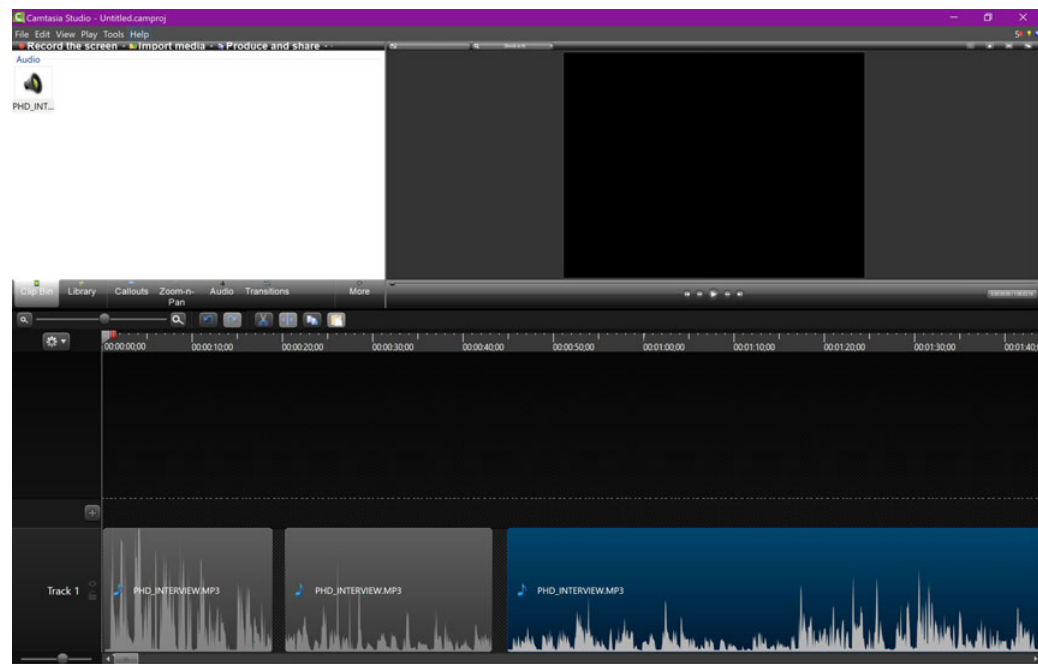
Fig. 3. Fourth-stage of oral narrative portraiture development: creating the audio